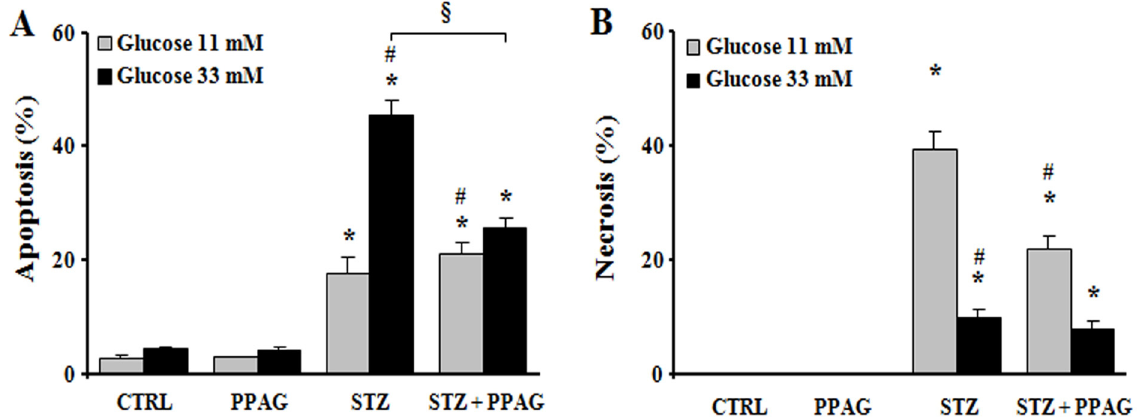
Fig 3. In vitro beta cell protection from STZ by PPAG. INS-1E cells were pre-treated with 30 μ M PPAG for 16 hours, exposed to 1 mM streptozotocin for 1 hour and then cultured for 23 hours in medium containing 11 or 33 mM glucose with or without PPAG (n = 3). The percentage of apoptotic (A) and necrotic cells (B) was determined following staining with the nuclear dyes propidium iodide and Hoechst 33342. A minimum of 500 cells was counted for each condition. Percentage of apoptotic (A) and necrotic cells (B). * p < 0.05 against control (CTRL). #p < 0.05 against STZ-treated cells in 11 mM glucose. §p < 0.05 as indicated.